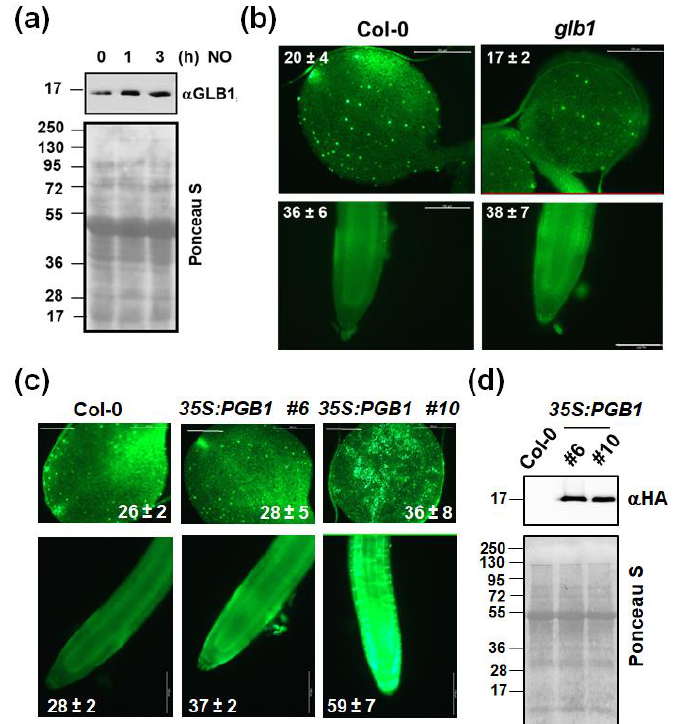
Figure 2. Effect of NO on GLB1/PGB1 protein levels and endogenous levels of NO in wild type, glb1 mutant, and PGB1 over-expressing transgenic plants. ( a ) GLB1/PGB1 protein levels at early times in hours (h) after plant exposure to NO were detected by Western blot with an anti ( α )-GLB1,2 antibody (Agrisera). Loading control is shown by Ponceau S stained membrane. The position of protein size markers (kDa) is shown on the left side. ( b , c ), Cotyledon (upper panels) and roots (lower panels) of the indicated mutant and transgenic overexpressing plants after treatment with DAF-FM diacetate. NO content values inside each panel are the average of 3 to 6 independent samples ± SE. White bars represent 500 and 100 μm for cotyledon and root images, respectively. ( d ) GLB1/PGB1 protein levels in HA-tagged PGB1 over-expressing transgenic plants were detected by Western blot with anti ( α )-HA-HRP antibody (Thermo Scientific). Loading control is shown by Ponceau S stained membrane. The position of protein size markers (kDa) is shown on the left